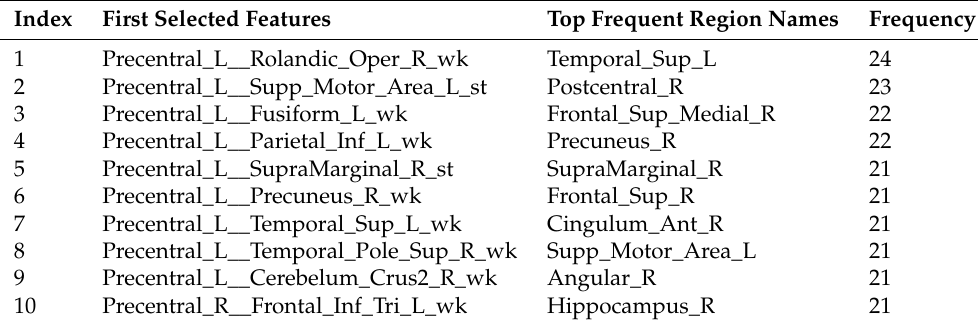
Table 5. Summary of first 10 selected features as well as the top frequent brain regions in this